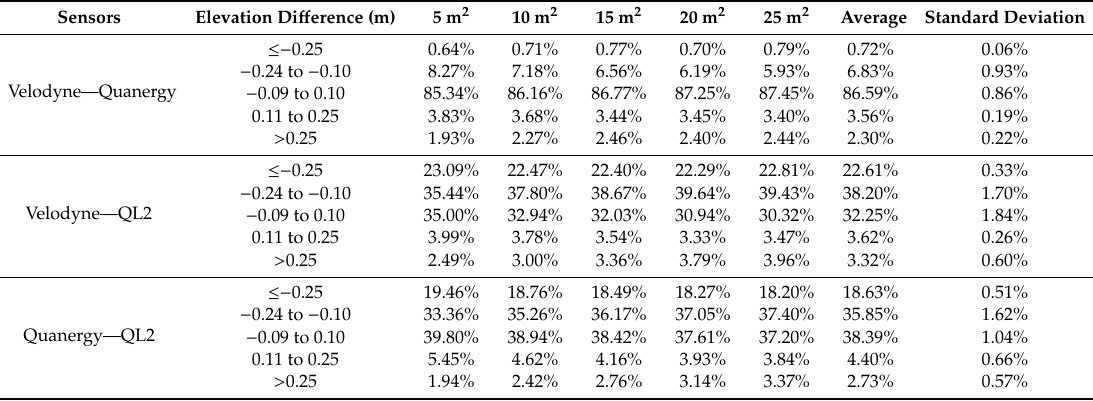
Figure 5. Mean elevation difference (in meters) for the 5 m 2 tessellation: ( A ) Quanergy M8, ( B ) Velodyne HDL-32E, ( C ) difference between the two UAS LiDAR sensors (Velodyne – Quanergy), ( D ) North Carolina Quality Level 2 (QL2) LiDAR elevation, ( E ) difference between Velodyne and QL2, and ( F ) difference between Quanergy and QL2. Table 6. Mean elevation difference (in meters) between each sensor (Quanergy, Velodyne and QL2 LiDAR) and tessellation size: percentage of study area by classes represented in Figure 6.